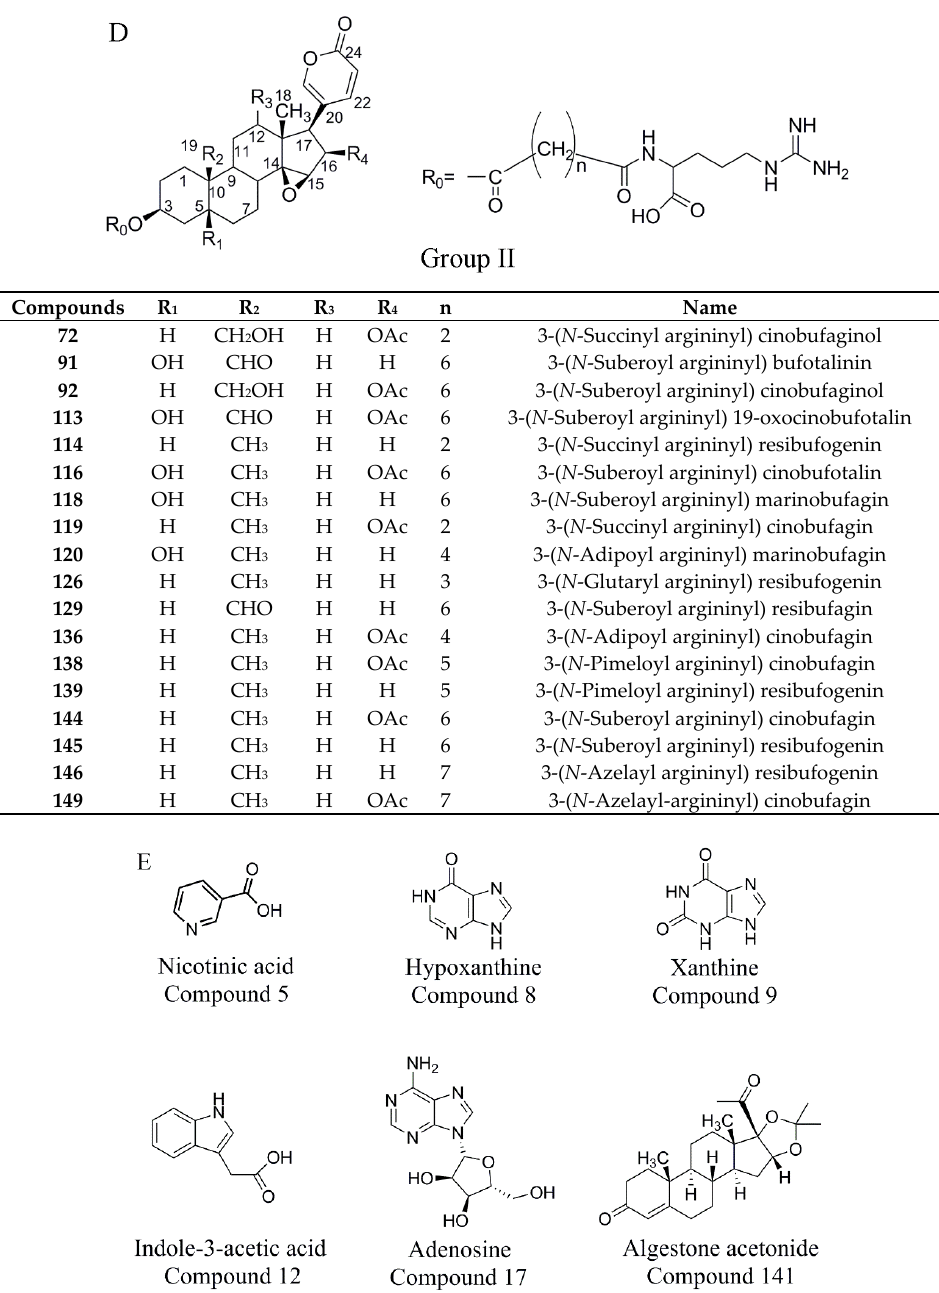
Figure 3. Chemical structures of compounds identified in the methanol extracts of Chansu. ( A ) amino acids; ( B ) alkaloids; ( C ) bufogenins (Group I: 14-hydroxy bufogenins; Group II: 14,15-epoxy bufogenins and Group III: Other bufogenins); ( D ) bufotoxins (Group I: 14-hydroxy bufotoxins and Group II: 14,15-epoxy bufotoxins); ( E ) other compounds. The prominent amino acids in Chansu were arginine and diacid-conjugated arginine. The diacid-conjugated arginine mainly contained C4 – C11 diacids, whose names are succinyl ( n = 2), glutaryl ( n = 3), adipyl ( n = 4), pimeloyl ( n = 5), suberoyl ( n = 6), azelayl ( n = 7), sebacyl ( n = 8), undecanedioyl ( n = 9) arginine, respectively. The MS/MS fragment of compounds 2 , 10 , 11 , 15 , 22 , 31 , 37 , and 42 at m/z 175.1177 – 175.1192 indicated the loss of diacid and the retention of arginine